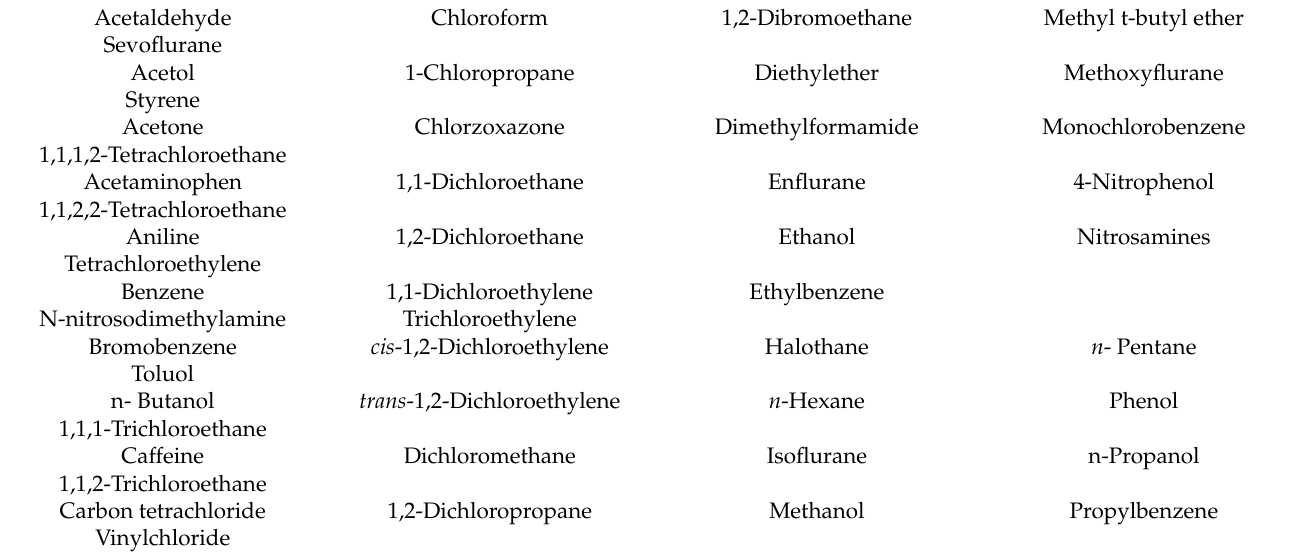
Table 2. Selected substrates of the hepatic microsomal CYP